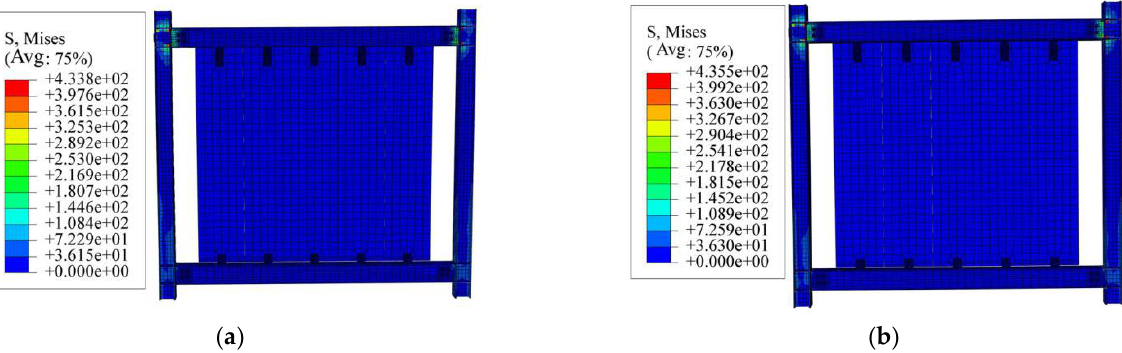
Figure 20. Comparison of stress nephograms of different bolt grades. ( a ) Stress nephogram of the grade 5.6 bolts. ( b ) Stress nephogram of the grade 8.8 bolts.